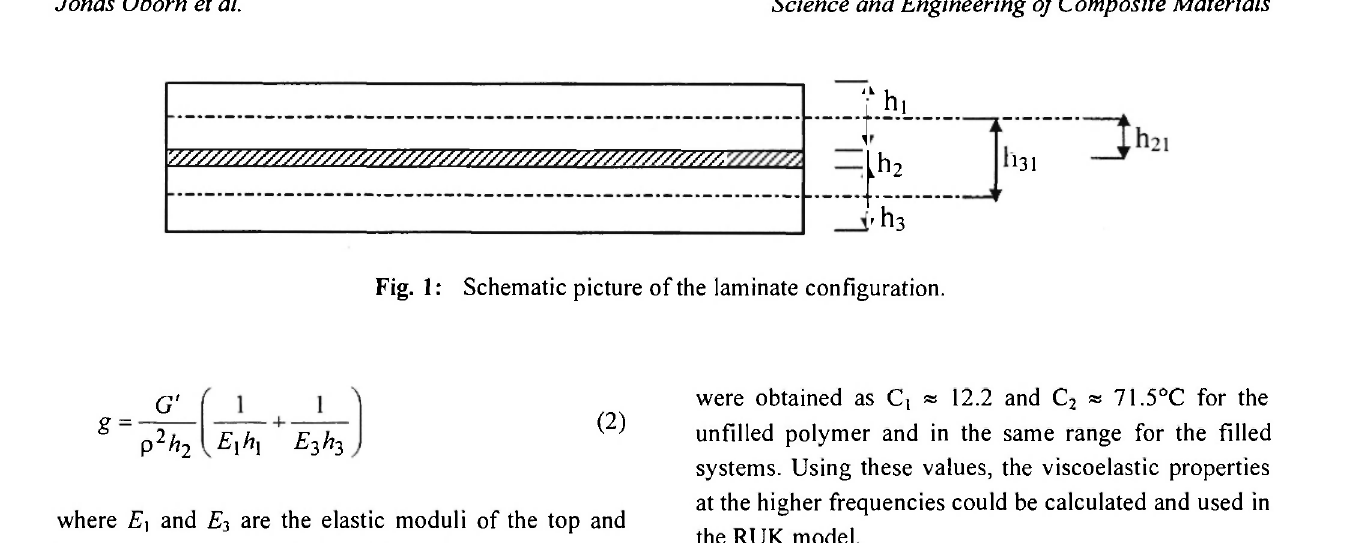
Fig. 1 : Schematic picture of the laminate